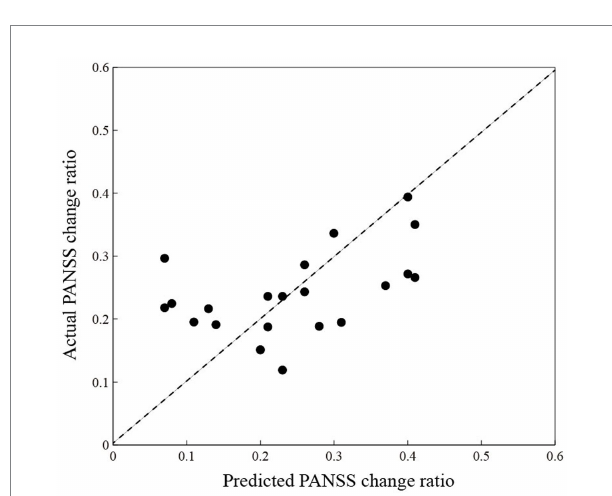
FIGURE 6 The correlation between predicted ( X -axis) and actual ( Y -axis) PANSS change ratios. The black-filled circles are individuals living with